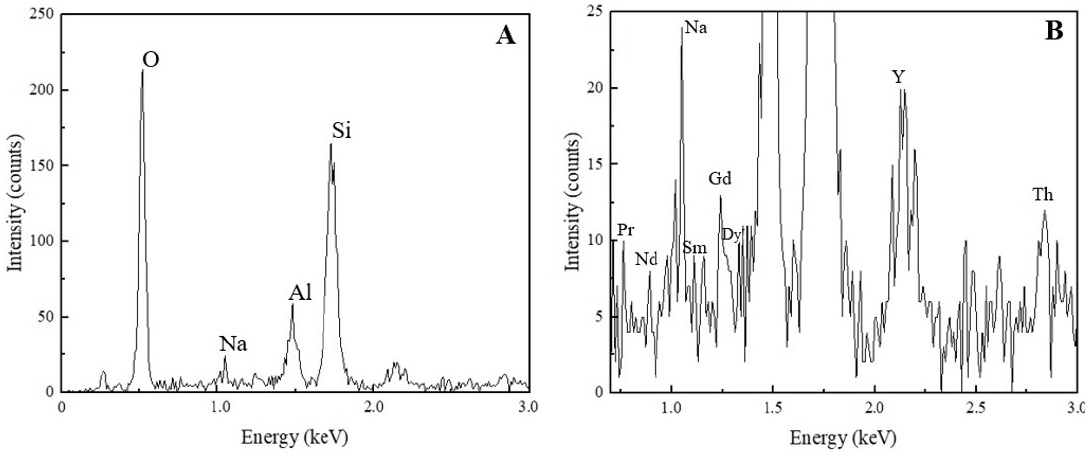
Figure 8. EDX pattern of the solid sample generated after Test 11. ( A ) Full EDX pattern indicating high-intensity elements. ( B ) Close-up view showing the detection of rare earths and thorium.